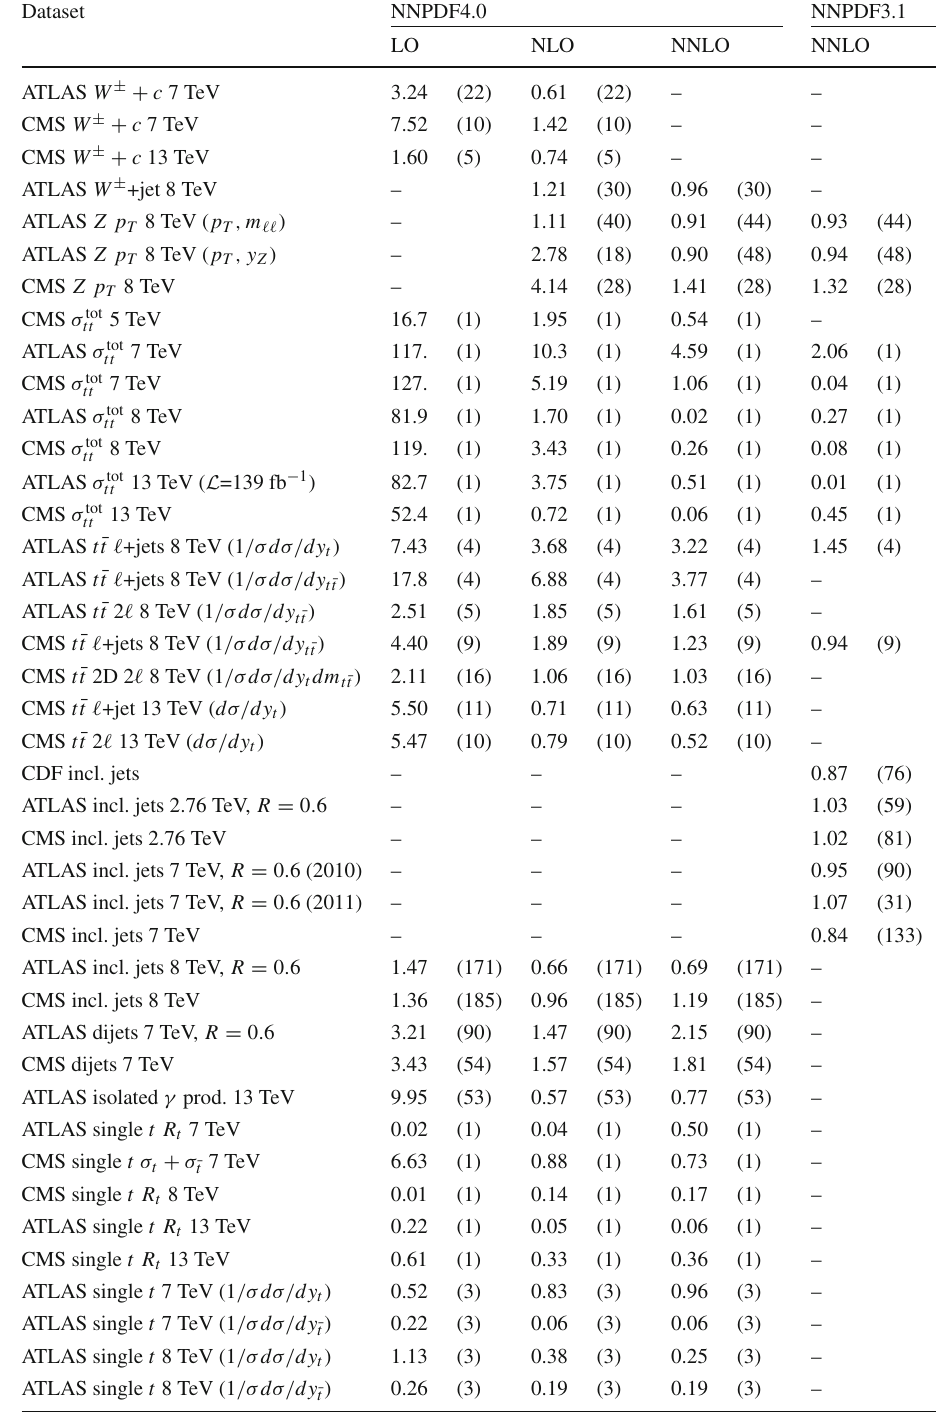
Table 22 Same as Table 19 for all other LHC